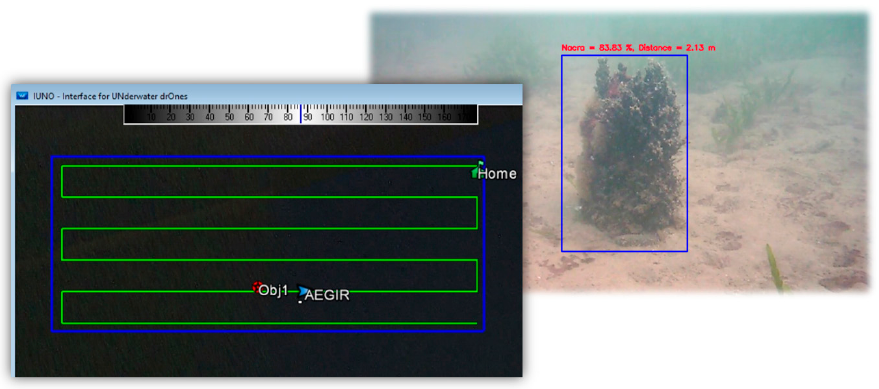
Figure 18. Specimen detection and positioning in IUNO.